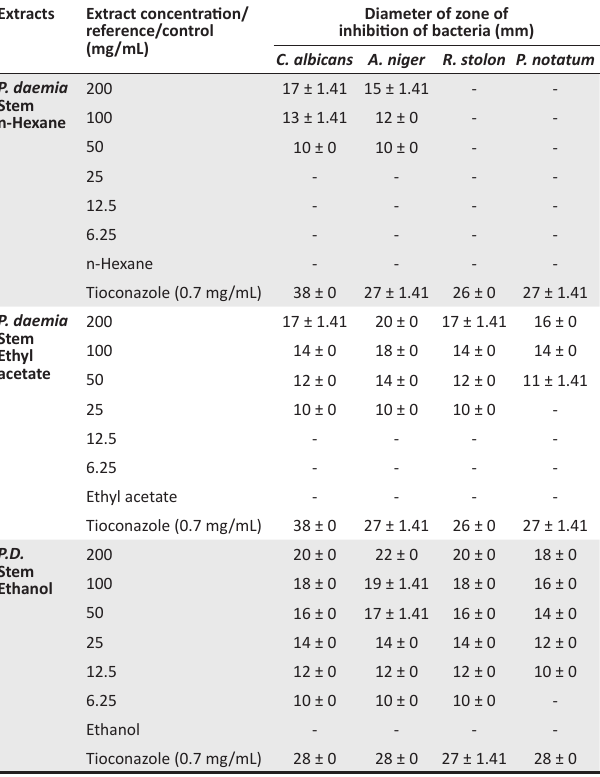
Diameter of zone of inhibition of bacteria (mm)